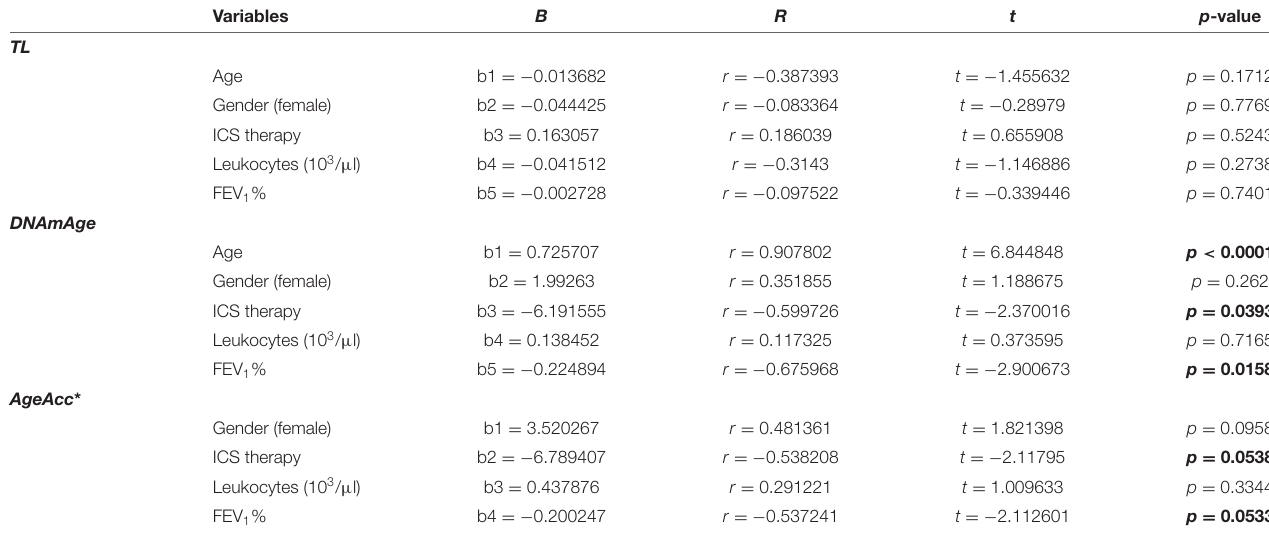
TABLE 3 | Multiple regression analysis (model a) of the influence of age, gender, ICS therapy, leukocytes (10 3 /ml), and FEV 1 % on blood leukocytes TL, DNAmAge, and AgeAcc.